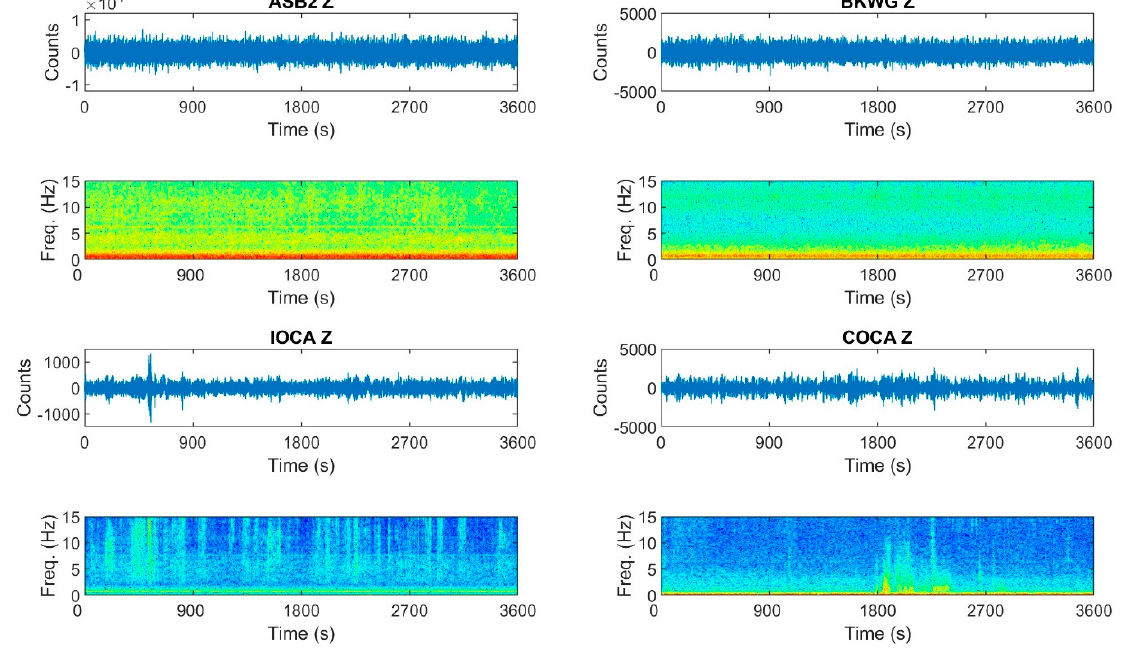
Figure 5. Examples of vertical component recordings of seismic noise and corresponding spectro- grams, at Campi Flegrei (ASB2 station), Ischia (IOCA station), Vesuvius (BKSG station), and Colima (COCA station).